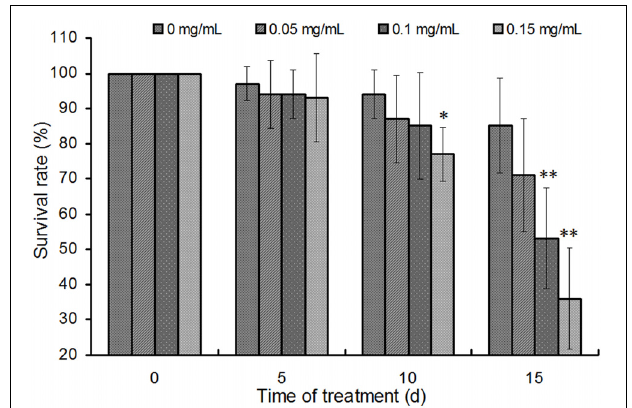
FIGURE 6 | Effects of schaftoside treatment on BPH. The results were expressed as the means ± SD from 10 independent experiments with 10 glass tubes (10 nymphs in each tube) examined for each treatment. The survival rates were analyzed by one-way ANOVA and Tukey HSD at each sampling time, and the asterisks on the bars indicated significant differences between the control (0 mg/mL) and the corresponding treatment group ( ∗ p < 0.05, ∗∗ p < 0.01).